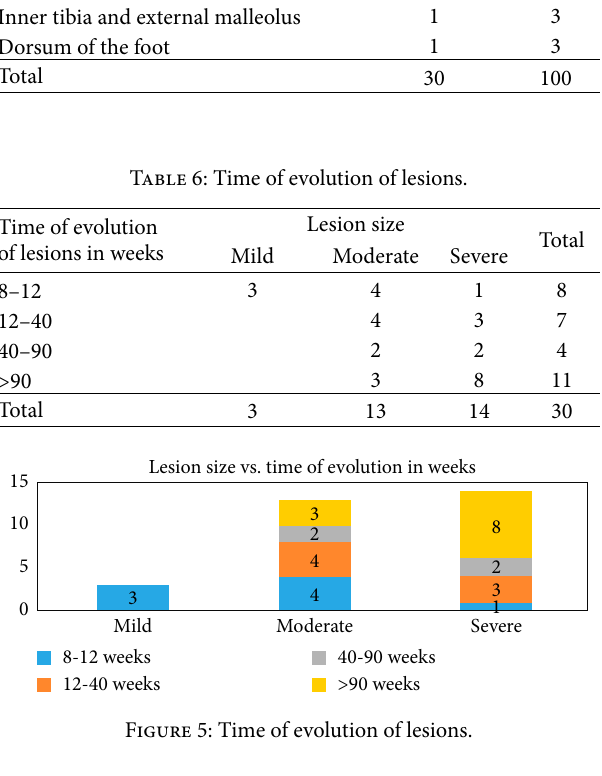
Figure 4: Number of lesions per patient.